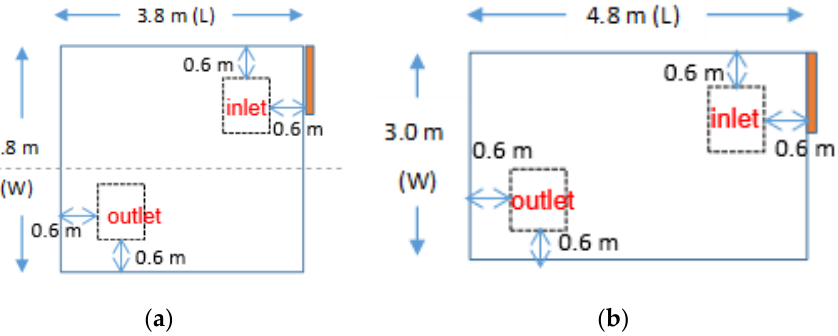
Figure 2. The location of air inlets and return air outlets on the ceiling. ( a ) square room, ( b ) rectan- gular room.